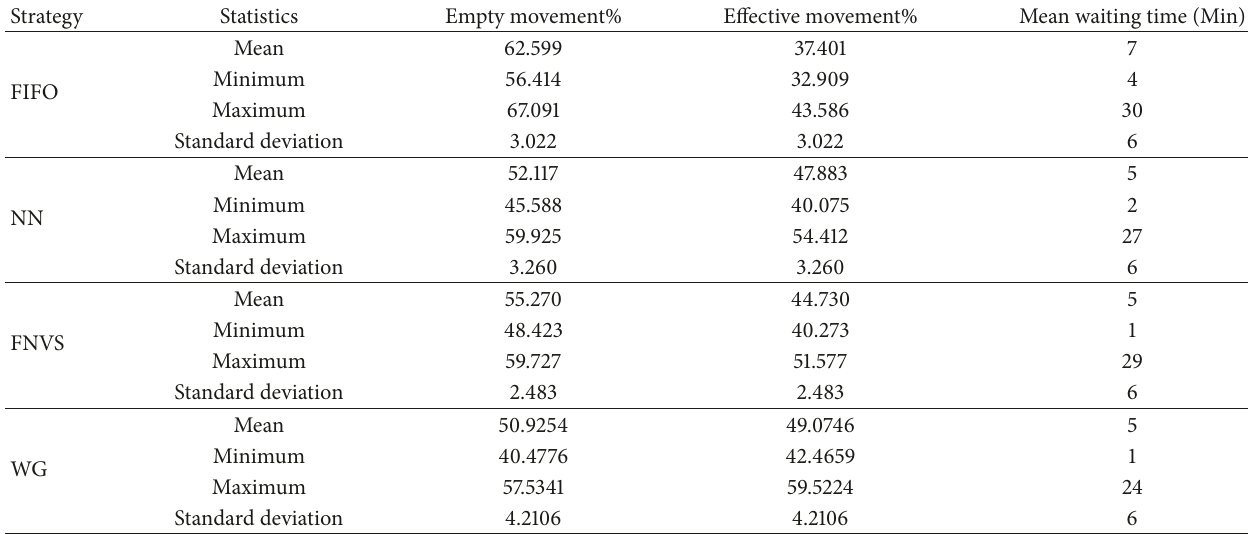
Table 4: Summary of the results of different